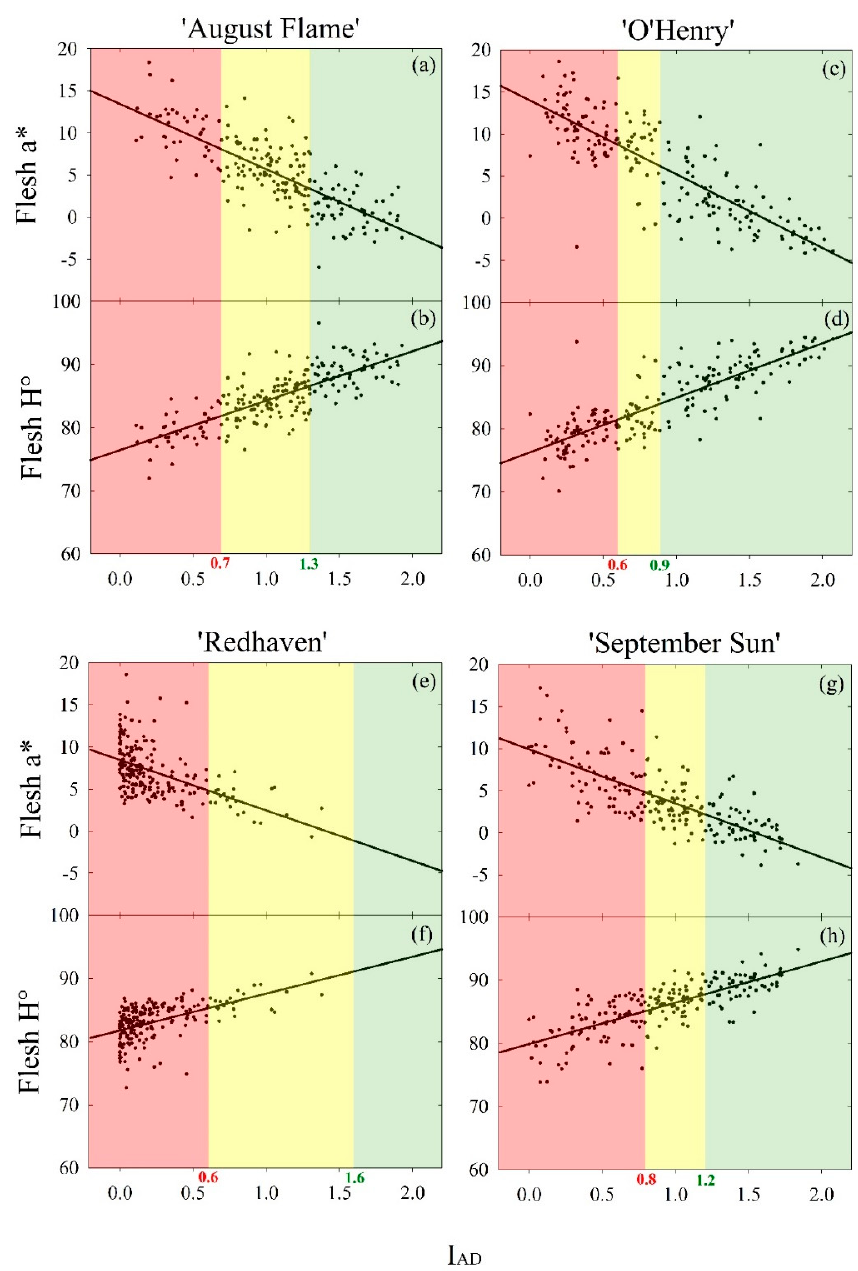
Figure 2. Scatter plots and linear regression fits of flesh a* and H° against the I AD in fruit ( n = 200) of four yellow peach cultivars at harvest (see Table 3 for regression coefficients). The three colours indicate I AD maturity classes reported in Table 1: (green) immature—no ethylene emission; (yellow) harvest-ready—onset of ethylene emission and (red) mature—ethylene emission peak. ( a ) Flesh a* and ( b ) H° vs. I AD in ‘August Flame’; ( c ) Flesh a* and ( d ) H° vs. I AD in ‘O’Henry’; ( e ) Flesh a* and ( f ) H° vs. I AD in ‘Redhaven’ and ( g ) Flesh a* and ( h ) H° vs. I AD in ‘September Sun’. Table 3. Linear regression models and predicted thresholds ( y ) of flesh a* and H° for the maturity classes “harvest-ready” and “mature” based on the indices of absorbance difference ( x ) reported in Table 1. Data reported for fruit of four yellow peach cultivars at harvest ( n = 200). Intercept, slope and